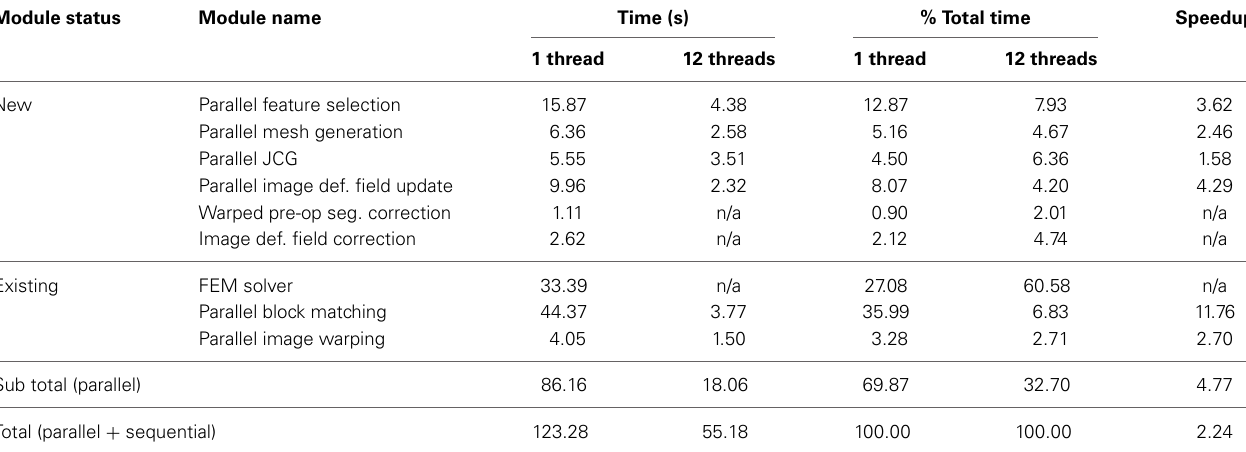
Table 5 | The performance of the APBNRR modules for case 13 with 1 and 12 hardware cores. Module